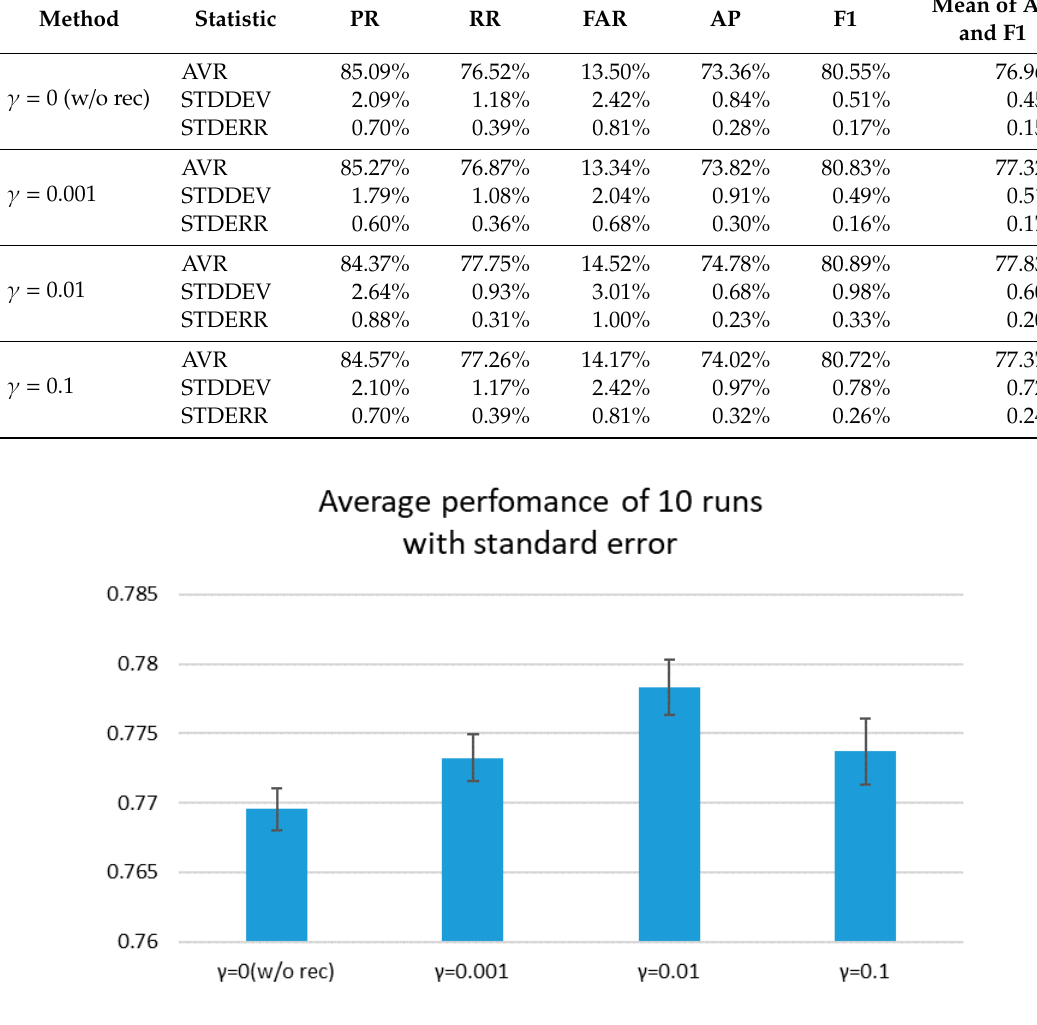
Figure 10. Average scores with various 𝛾 .